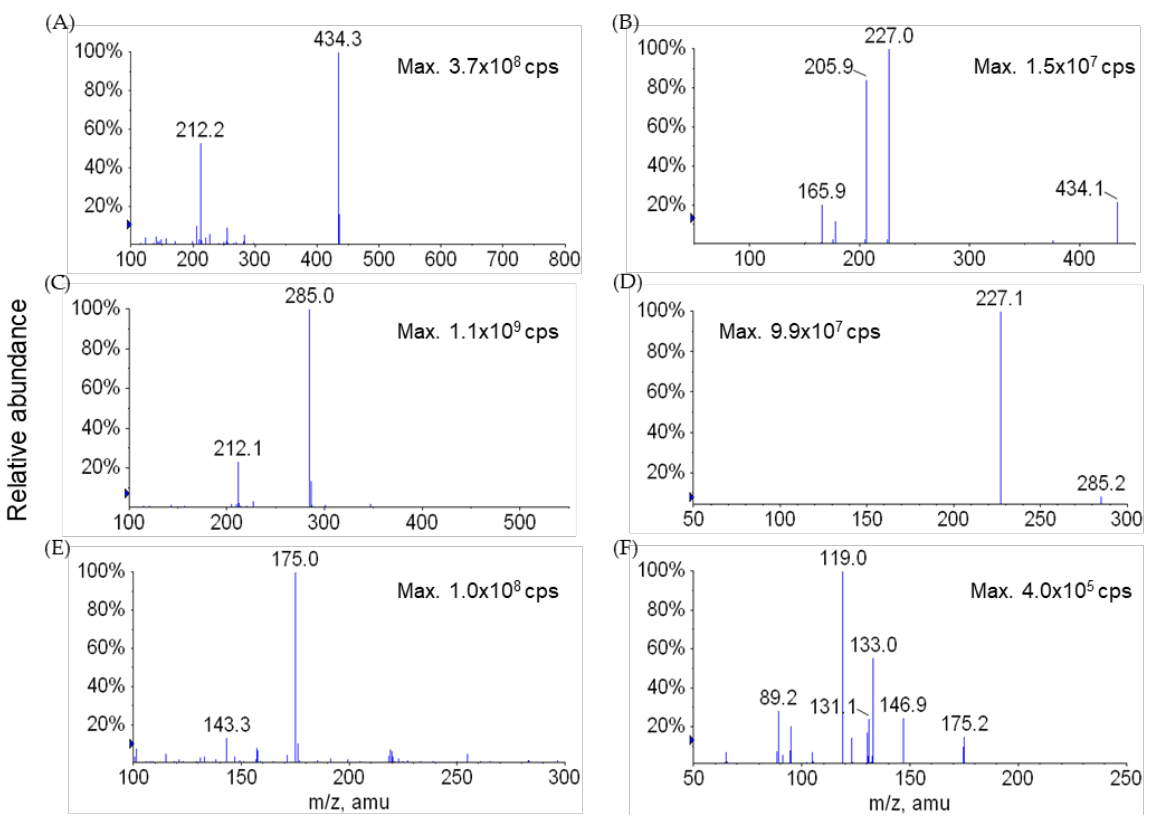
Figure 6. ESI negative Q1MS ( A , C , E ) and MS/MS product ion ( B , D , F ) spectra for LW6 ( A , B ), APA ( C , D ), and the internal standard ( E , F ).